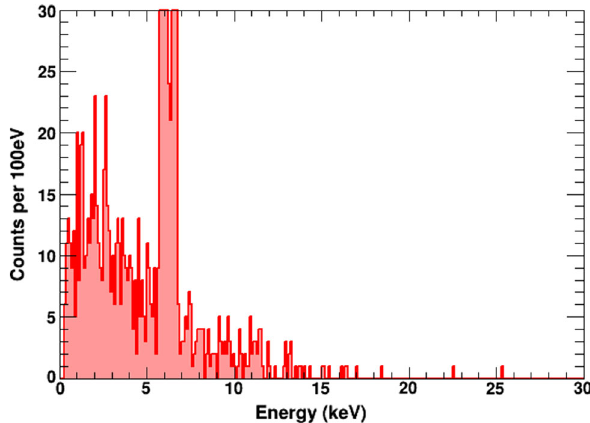
Fig. 2 Energy spectrum of all events in the previously defined accep- tance region from the detector module Lise . The range in the y-axis is chosen for reasons of clarity, although a few bins surpass the upper